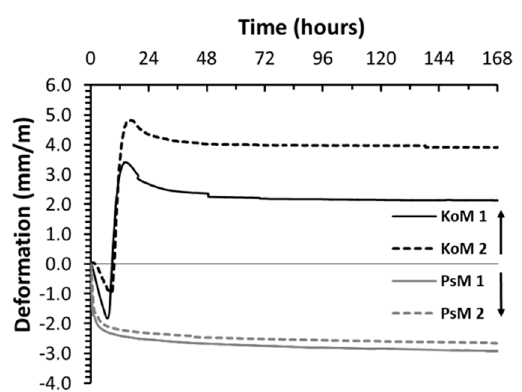
Figure 6. Autogenous shrinkage of alkali-activated mortars.